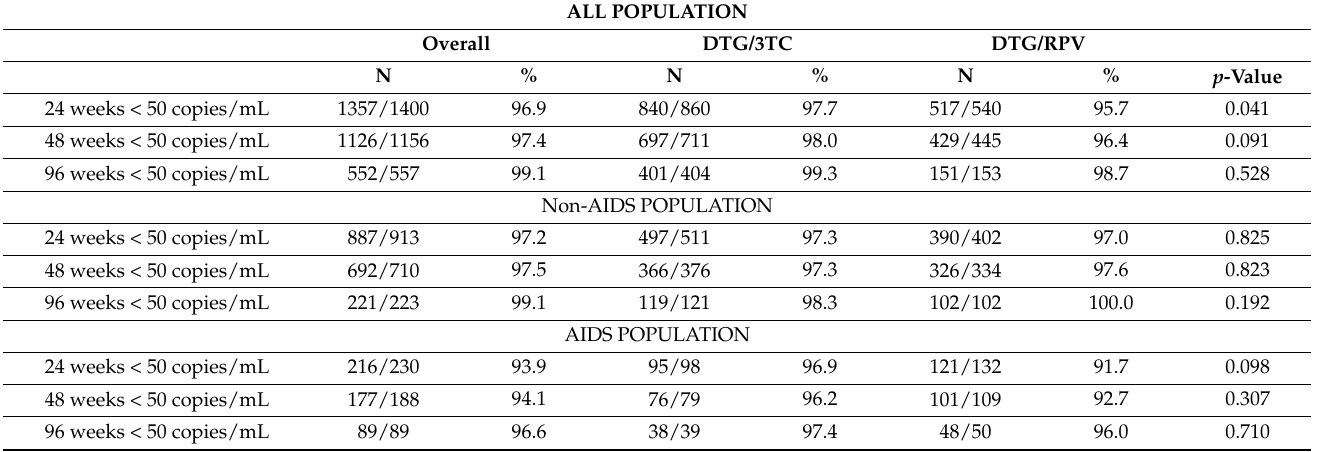
Table 2. Rate of virological suppression at weeks 24, 48, and 96 by treatment in the overall population, no-AIDS population, and AIDS population.